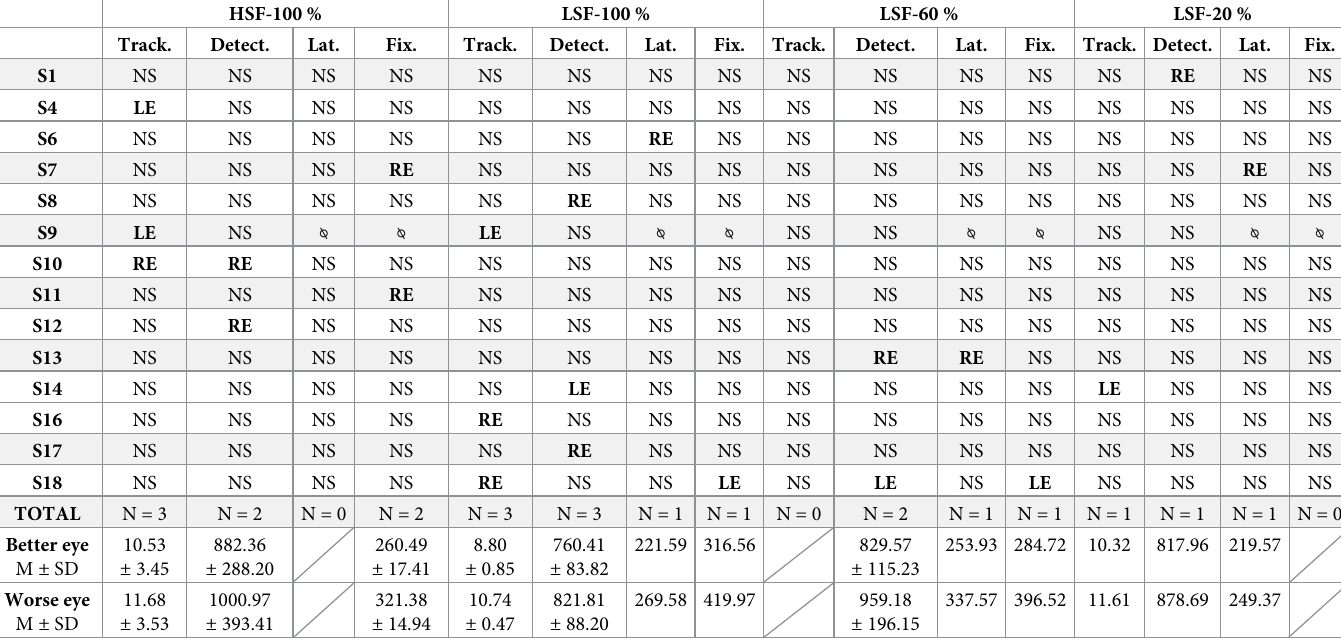
Table 2. Paired t-test between the right and the left eye performances for each participant under the four background conditions. HSF-100 %